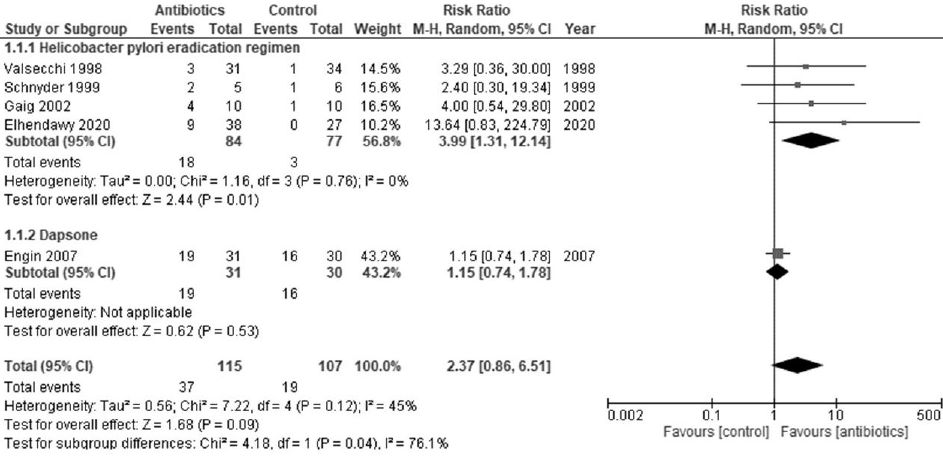
Figure 2. Forest plot of the remission